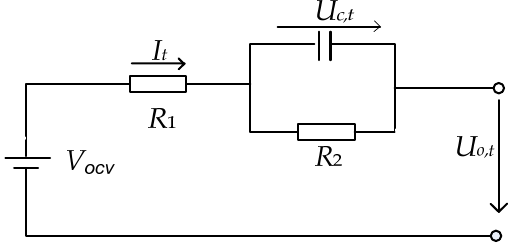
Figure 1. Thevenin topology for lithium-ion battery.